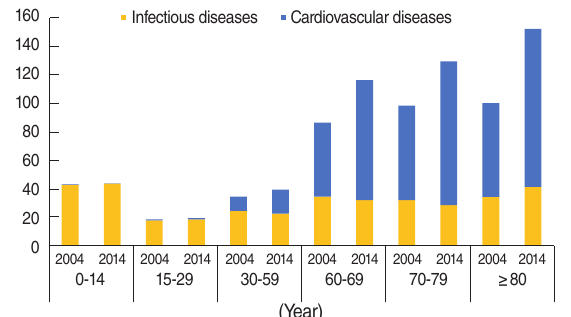
Figure 1. Prevalence of infectious and cardiovascular diseases from 2004 to 2014 by age.